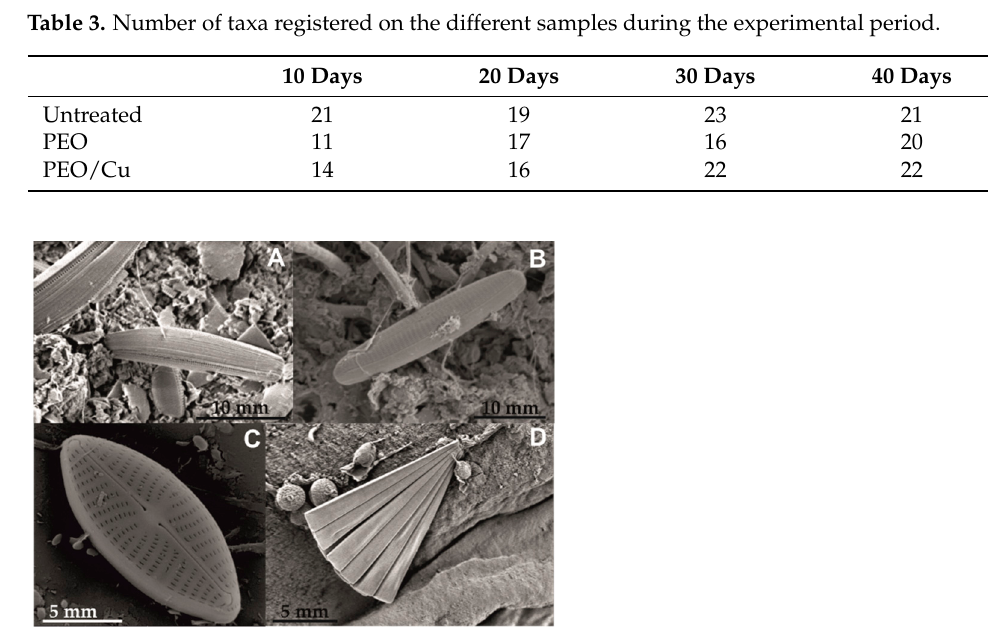
Figure 14. Scanning electron micrographs showing some diatoms found in the samples. ( A ) Amphora sp., bar = 10 µm; ( B ) Navicula sp., bar = 10 µm; ( C ) Navicula sp., bar = 5 µm; ( D ) Licmophora sp., bar = 5 µm. Table 3. Number of taxa registered on the different samples during the experimental period.